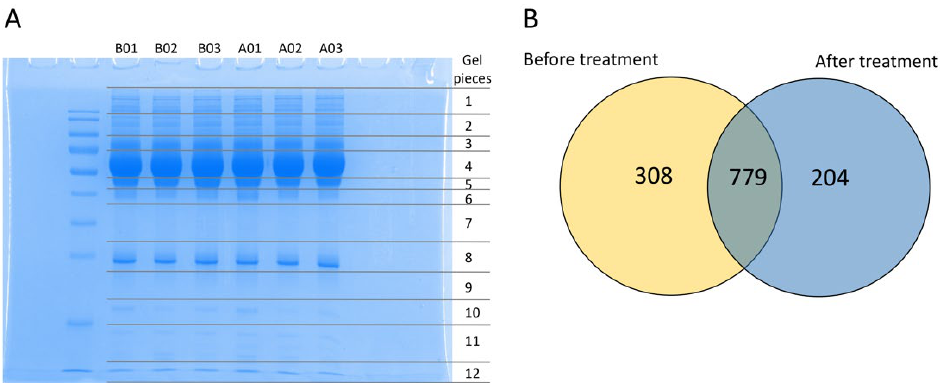
Figure 1. The label-free quantitative proteomic analysis of plasma specimens from the mulberry leaf treatment study. ( A ) SDS-PAGE gel stained with Coomassie Blue-R of plasma proteins from the before and after treatment group. Each lane represents the plasma samples from before treatment with triplication (B01, B02, and B03, respectively) and after treatment with triplication (A01, A02, and A03, respectively). ( B ) The illustration of the total of 1291 proteins revealed 308 and 204 differentially expressed proteins expressed in the before and after treatment groups, respectively. The overlapping 779 proteins indicated the number of altered proteins shared between the before and after treatment groups.